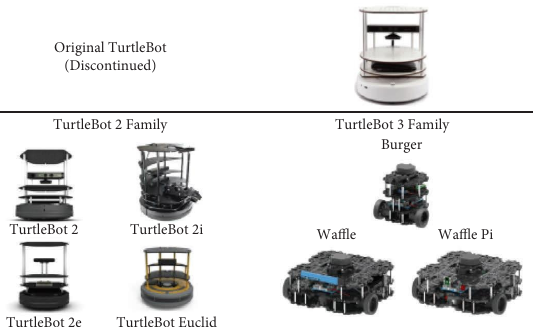
Figure 1: Turtlebot